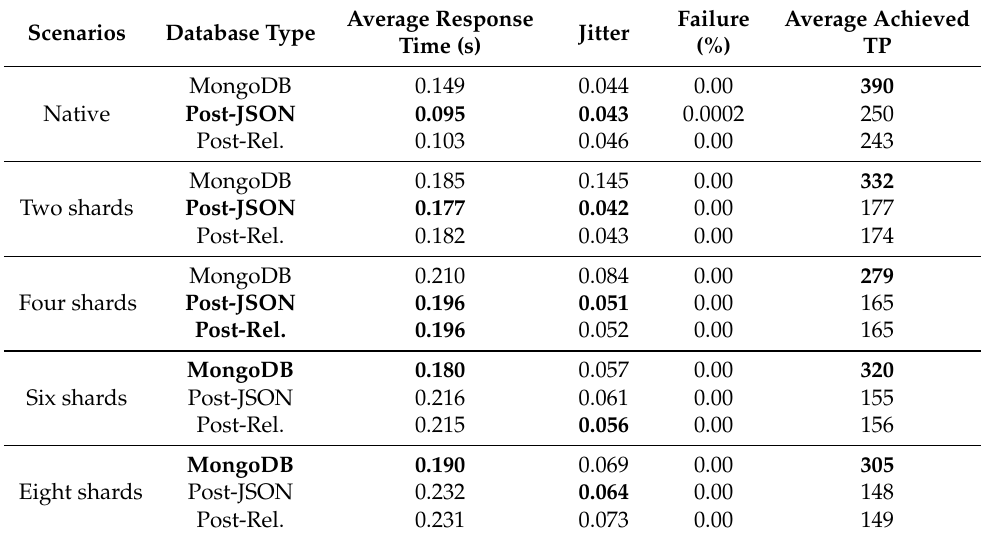
Table 1. Average of response time and throughput, jitter and failure in MongoDB, Postgres JSON and Relational PostgreSQL for the representative case of 10 K client throughput in the insert (Q1) case. Scenarios